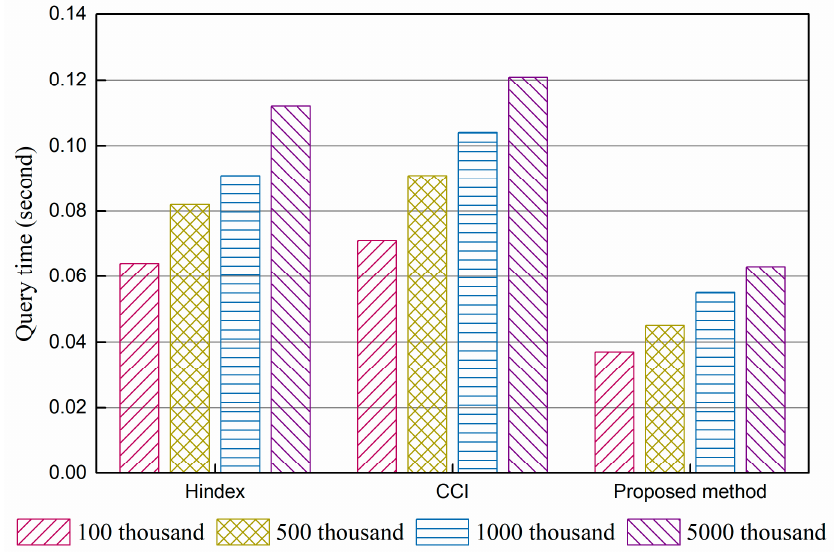
Figure 4. Results of a single-column query performance experiment.